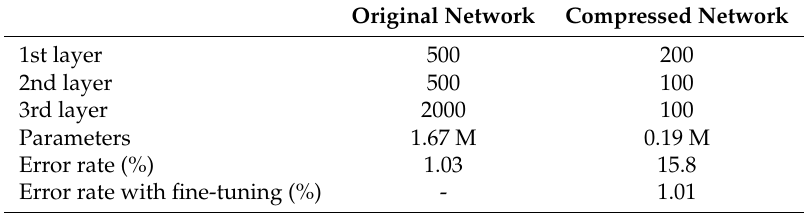
Table 2. Architecture and performance of the compressed network with a high compression